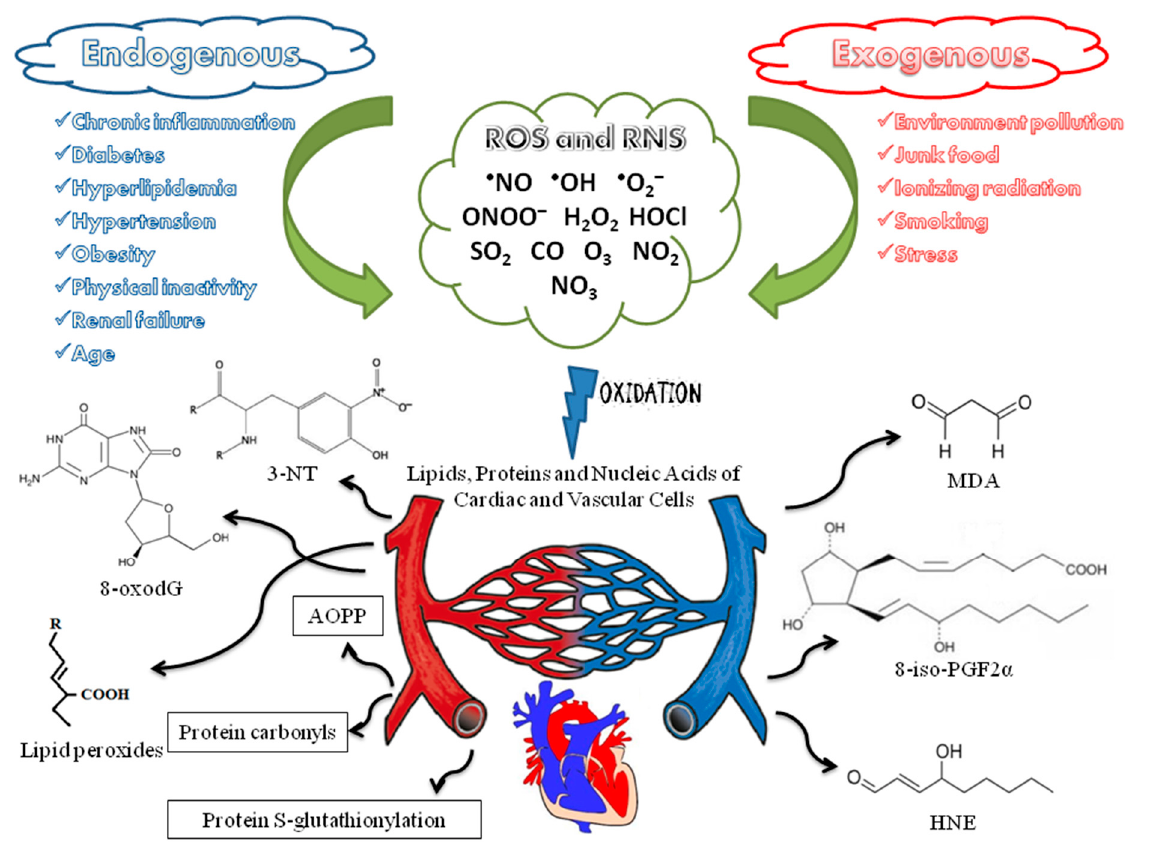
Figure 1. The sources and effects of oxidative stress that promote cardiovascular diseases. • NO—nitric •